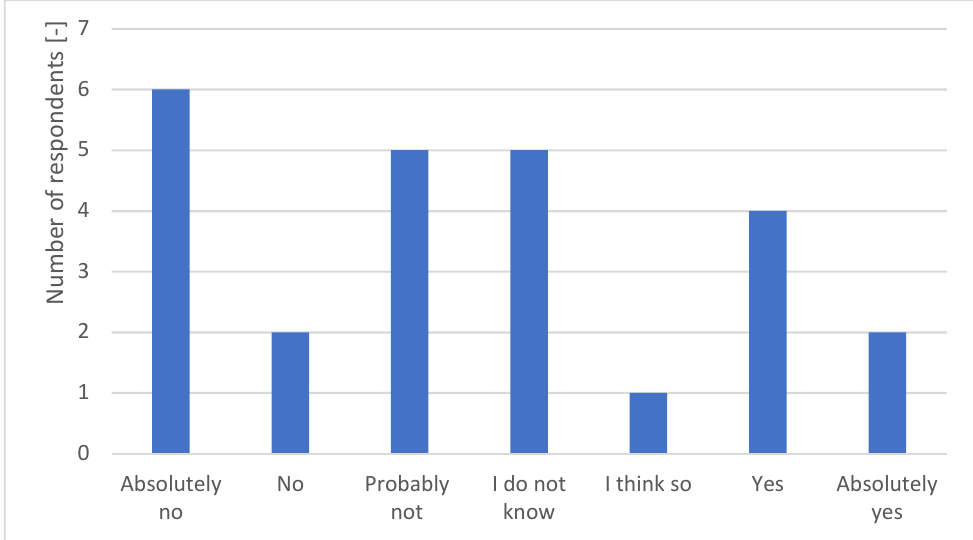
Figure 13. Willingness to engage in open innovations of the competition.